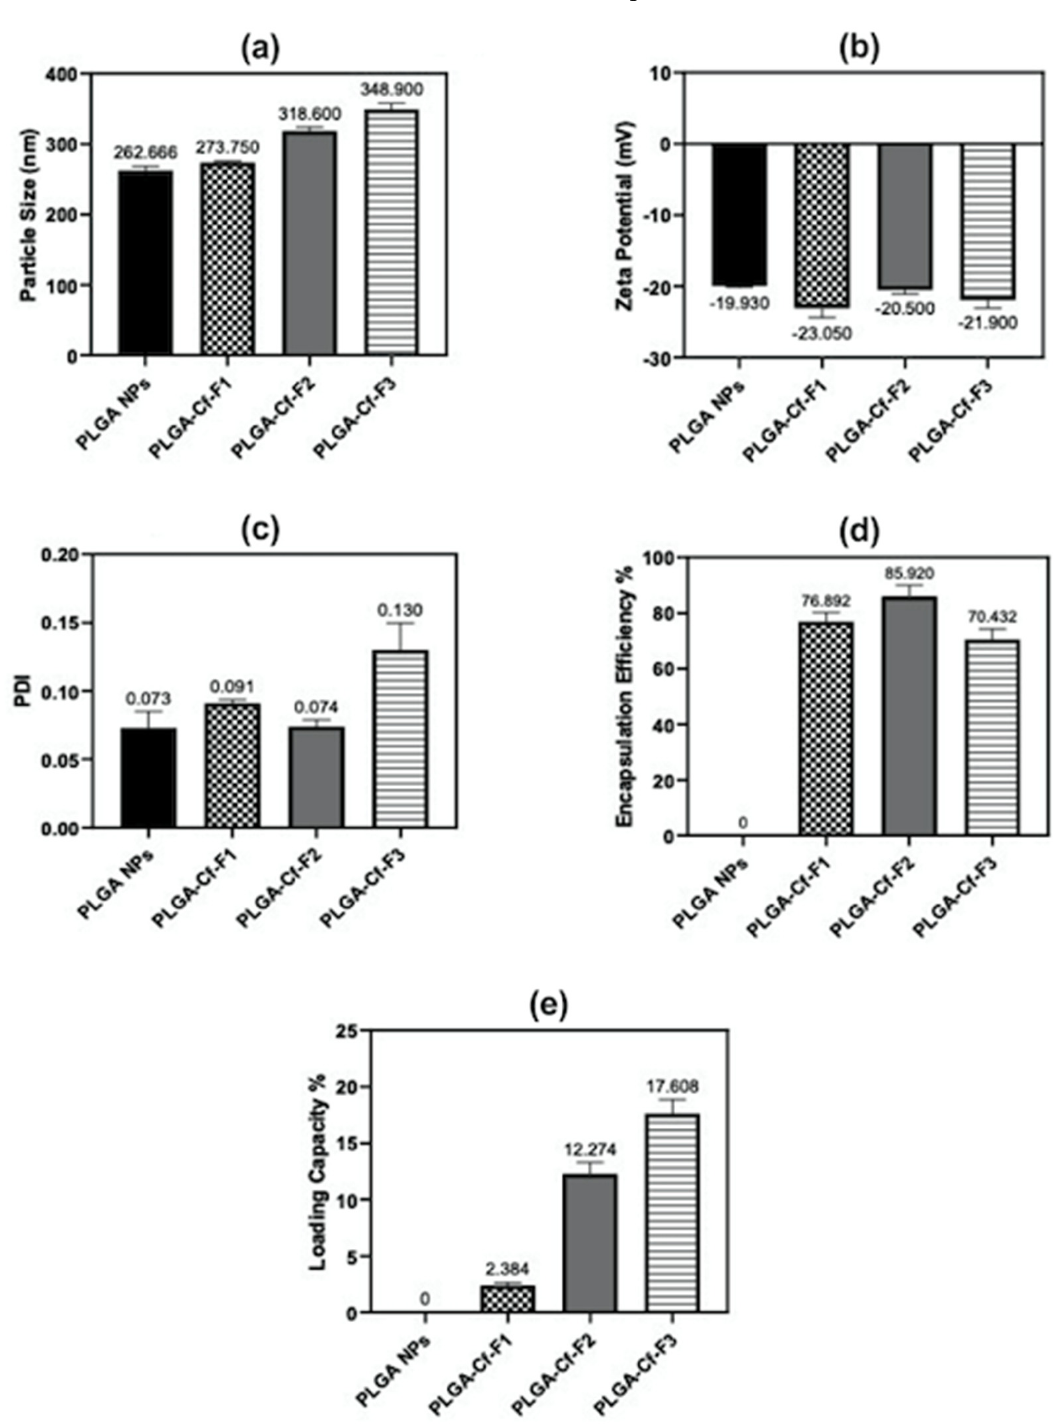
Figure 3. Bar charts representing the impact of increasing the initial drug amount on: average particle size ( a ), ZP ( b ), PDI ( c ), EE% ( d ) and LC% ( e ) for PLGA NPs and PLGA-Cf-F 1 , -F 2 , and -F 3 .